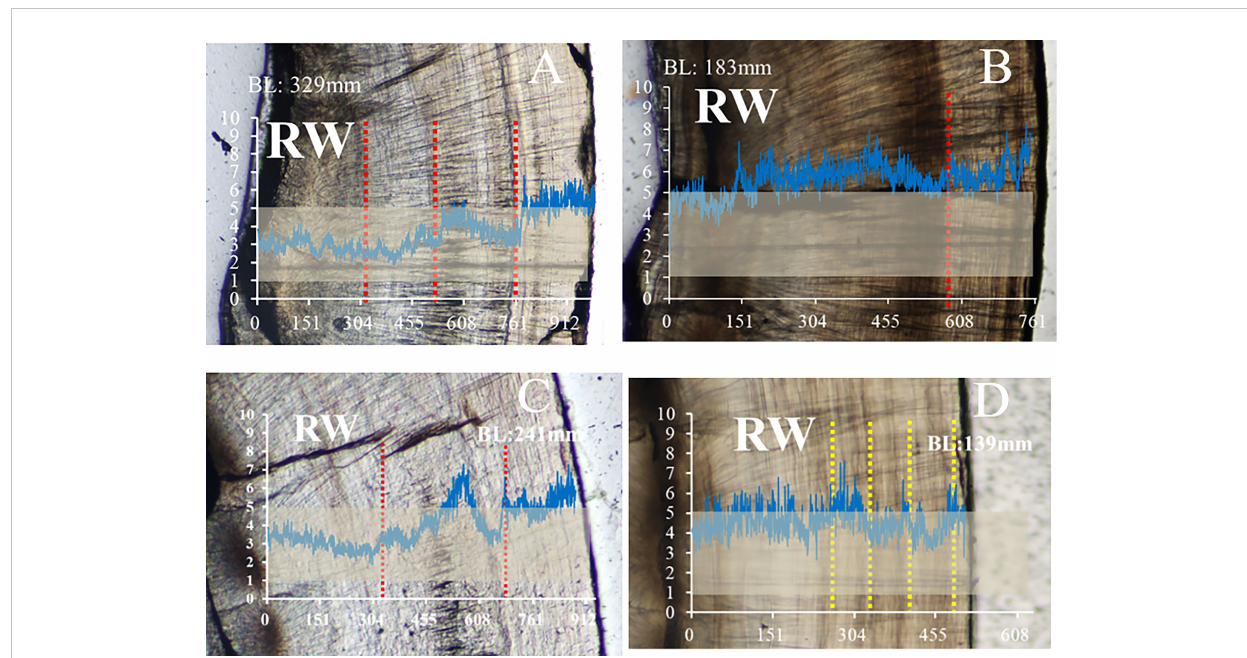
FIGURE 6 Sr/Ca ratio pro fi les of A. latus of different ages from RW. Individual size (Body length, BL) and habitat are also included in each graph. The vertical red dashed lines indicate mean annual growth increments; the yellow line indicates the month age (ring) position and the grey area indicates that the individual lives in the low to middle salinity area. Y-axis is Sr/Ca ratio. X-axis is distance to the core (mm). (A) the 3-year-old individual (BL:329 mm), (B) the 1-year-old individual (BL:183 mm), (C) the 2-year-old individual (BL:241 mm), (D) the under-1-year-old individuals(BL:139